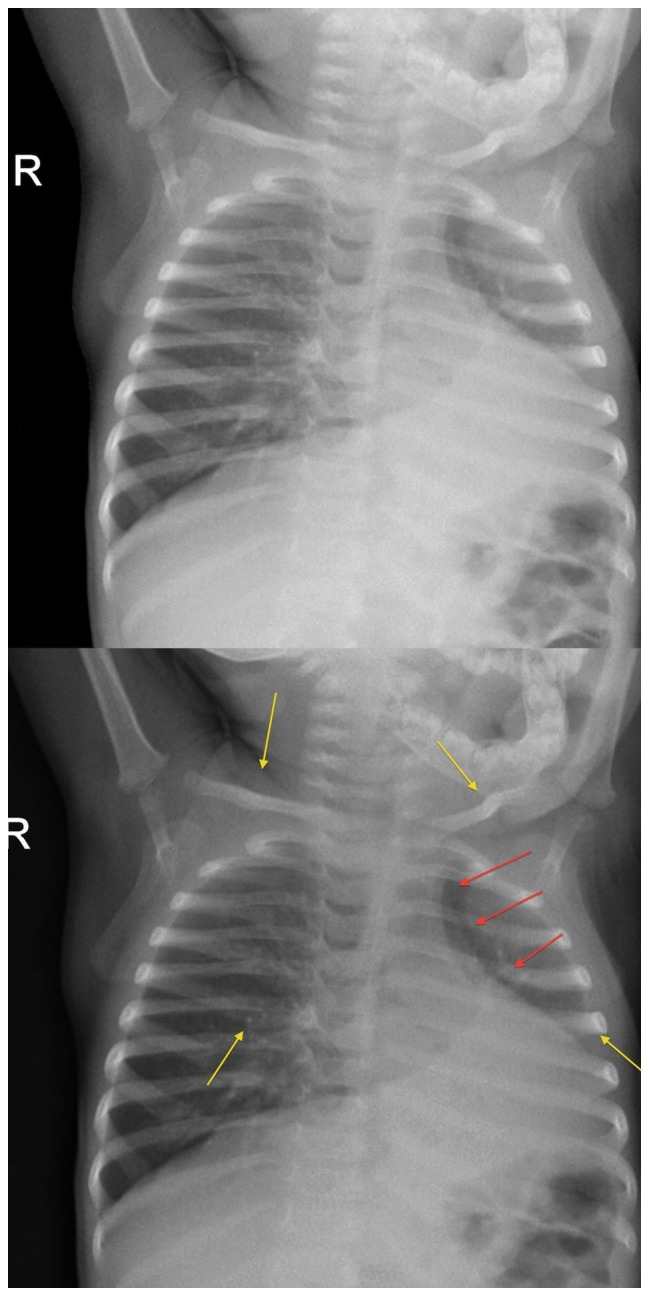
Tutorial for technicians.Note: This and other similar tutorials were produced to teach technicians how to improve image quality through the functions provided by the digital system.